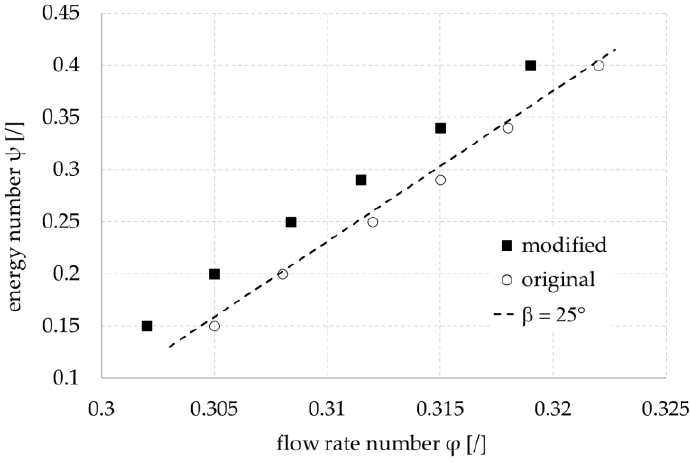
Figure 6. Turbine measuring